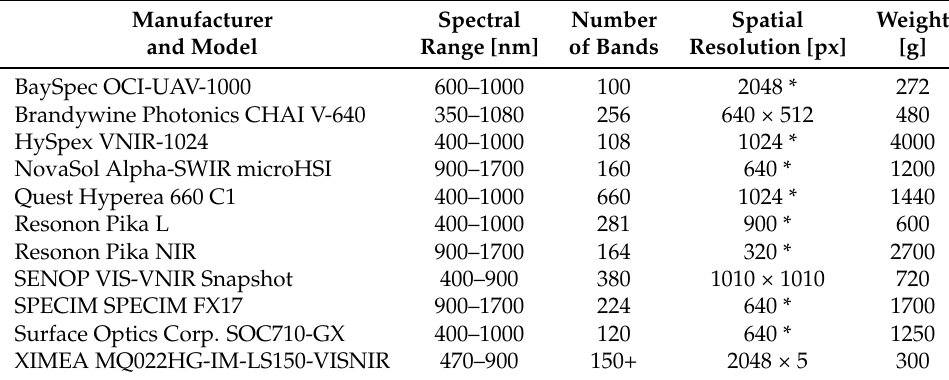
Table 5. Main parameters of some hyperspectral sensors available for being coupled with UAS, modified from Adão et al.